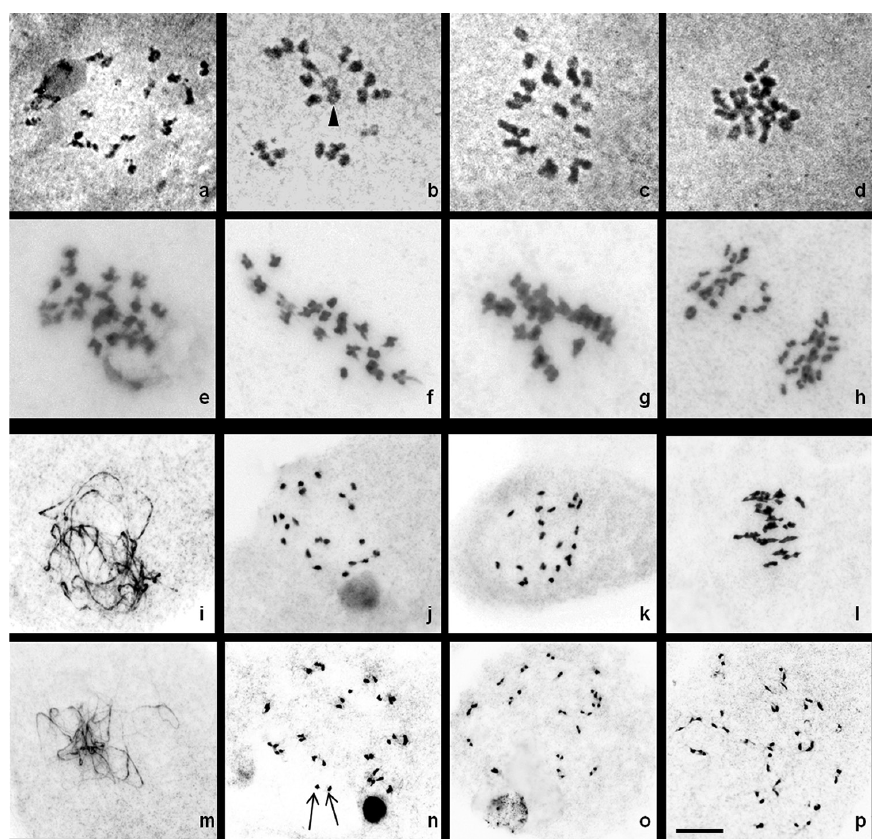
Figure 1. Male meiosis in group I. a–d C. comosa : a diplotene b diakinesis c–d metaphase I e–h C. haritha : e diakinesis f metaphase I g–h anaphase I i–l C.mangga : i pachytene j diplotene k diakinesis l metaphase I m–p C. montana : m pachytene n diplotene, o–p diakinesis; arrowhead showing multivalent and